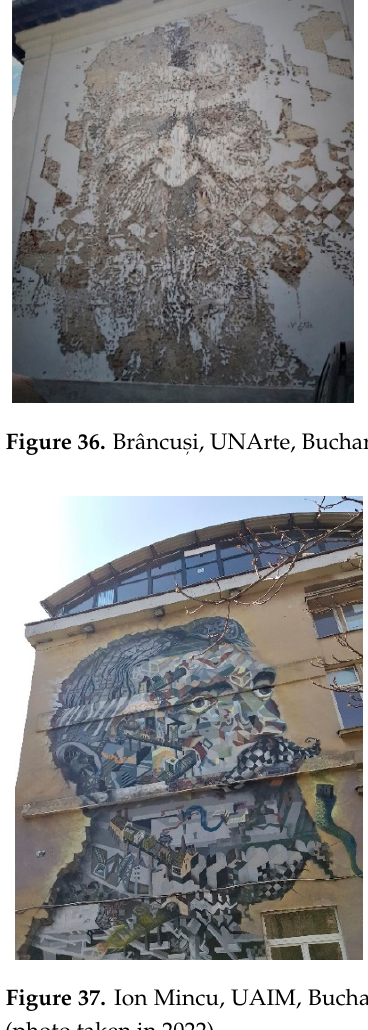
Figure 38. Vlad Ț epes and Bram Stoker, Ș tirbei Vod ă st., Bucharest by Obie Platon, 2014 (photo taken in 2022). Another example comes from the cinematographic Romanian history. In 2020, with the 100th anniversary of the first Romanian animated film, in the framework of the “Animest—International Animation Film Festival”, organized in Bucharest, an exhibition was dedicated to the most important moments in the history of local animated cinema and hosted by the cultural hub BRD Scena9 Residence. There, Romanian cartoon charac ‐ ters in relation to the history of the Romanian cartoons by Sorina Vazelina, Gri, Suzi, and Jo were represented: the first cartoon character, the well ‐ known old children’s story trans ‐ posed in animation and the evolution of films in socialist times (e.g., “Gopo’s Little Man”, the creation of Ion Popescu ‐ Gopo, a prominent personality in the Romanian cinematog ‐ raphy and the founder of the modern Romanian cartoon school, or “Mihaela and Azorel”, a cartoon series from the 1970s and 1980s). The national symbols are accompanied by rep ‐ resentations of some international animation characters (e.g., “Pinocchio”) [18]. Murals of larger or smaller dimensions have spread as well in other areas of Bucha ‐ rest: e.g., near the Romanian Orthodox Patriarchal Cathedral a paste ‐ up as a tribute to two emblematic artists for the national culture can be found, Anda C ă lug ă reanu and Mar ‐ gareta Pâslaru, an artwork signed by Sweet Damage Crew. On a transformation station located inside an important park in the northern part of the capital (and previously men ‐ tioned in the typology of media for graffiti and street art works) the pioneers of the Ro ‐ manian aviation are highlighted (work of Fear and Suflo): Traian Vuia—inventor of the first aircraft with its own means of propulsion, with which he made the first flight in hu ‐ man history in 1906, rising from the ground by own means of the machine; Aurel Vlaicu—